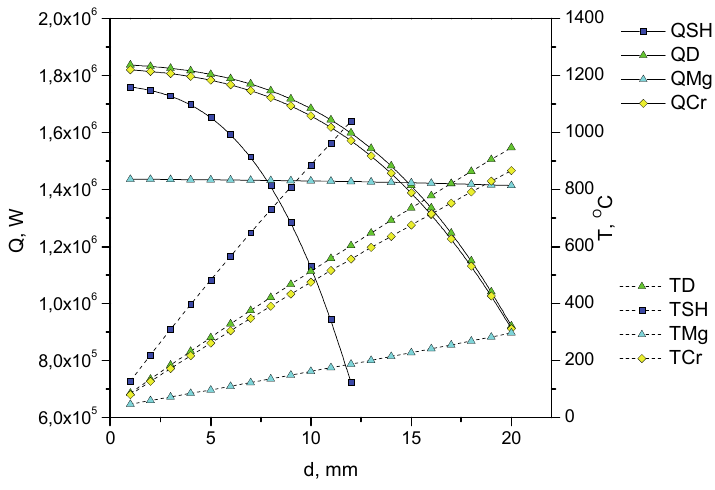
Figure 10: Heat losses and surfaces temperature of insulations as a function of insulation